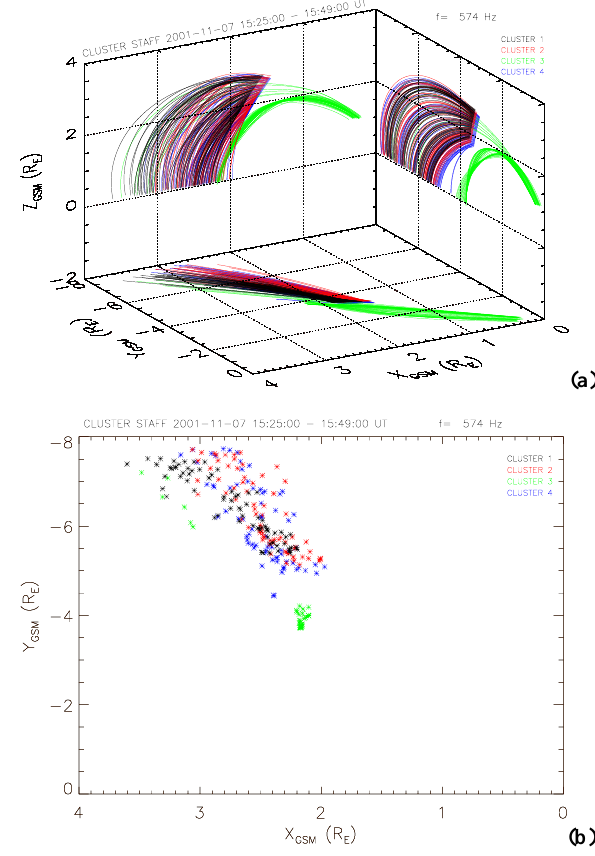
Fig. 8. Results of the ray tracing performed on 7 November 2001 between 15:25 and 15:49UT at a frequency equal to 574Hz. (a) In comparison to Fig. 3a, here all the rays are represented during the given time interval. (b) Location of the equator crossing in the equatorial plane for each SC.